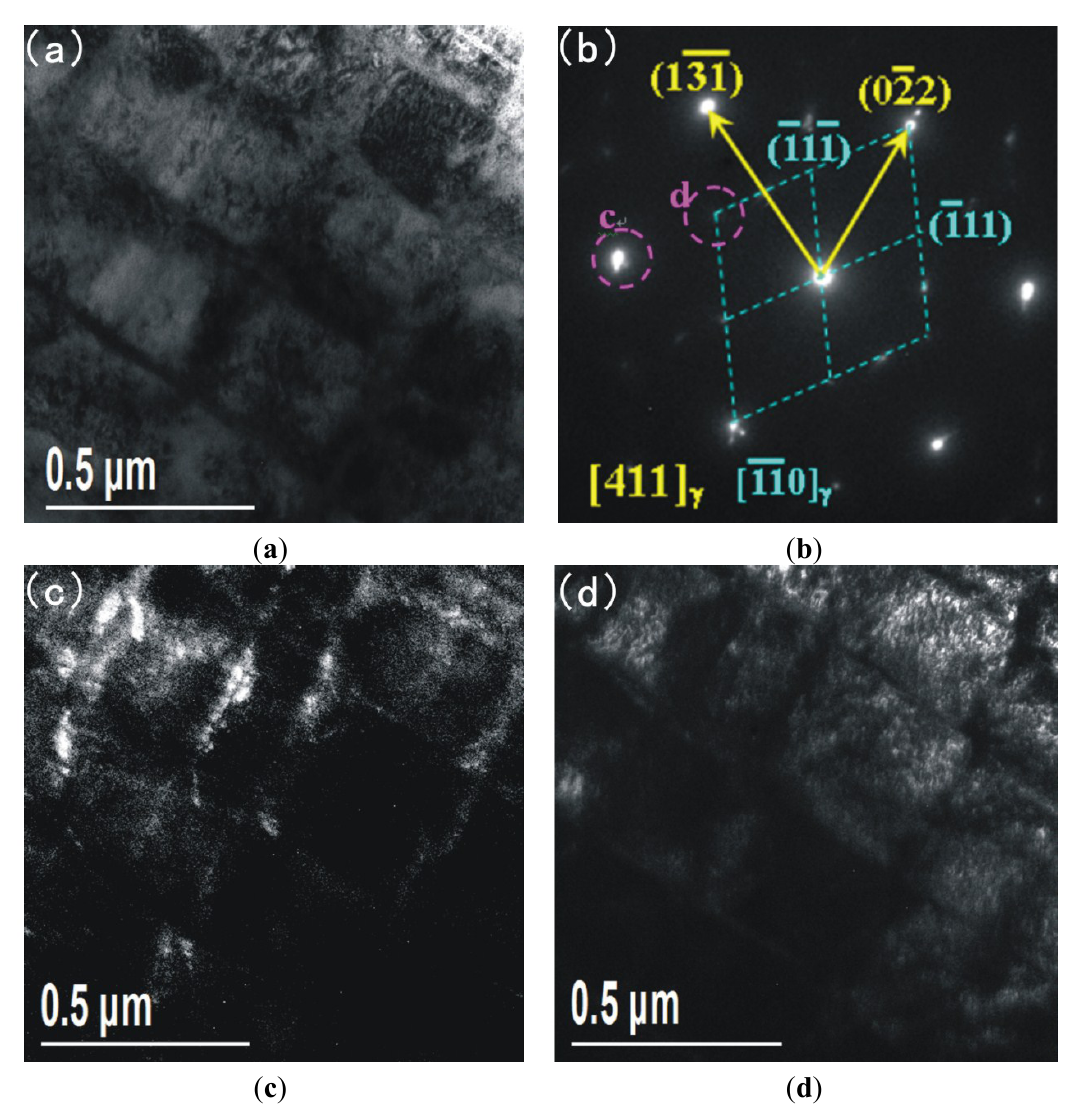
Figure 8. TEM and corresponding diffraction patterns of HAZ; ( a ) bright field image; ( b ) corresponding diffraction patterns; ( c ) and ( d ) dark field